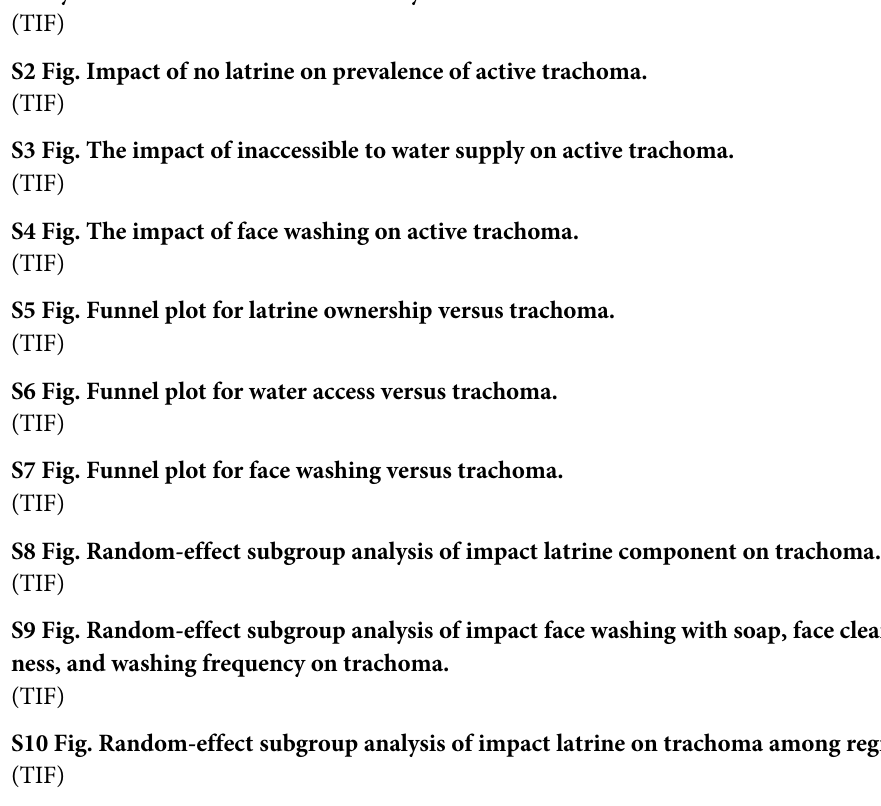
S2 Table. Summary of subgroup analysis examining the association of latrine exposures with active trachoma in Ethiopia, 2021. S3 Table. Summary of subgroup analysis of face washing with soap, frequency, and face cleanliness on active trachoma in Ethiopia, 2021. S4 Table. Newcastle–Ottawa quality assessment scale adapted for meta-analysis. S1 Fig. PRISMA flow diagram of included studies. PRISMA, Preferred Reporting Items for Systematic Reviews and Meta-Analyses. S2 Fig. Impact of no latrine on prevalence of active trachoma. S3 Fig. The impact of inaccessible to water supply on active trachoma. S4 Fig. The impact of face washing on active trachoma. S5 Fig. Funnel plot for latrine ownership versus trachoma. S6 Fig. Funnel plot for water access versus trachoma. S7 Fig. Funnel plot for face washing versus trachoma. S8 Fig. Random-effect subgroup analysis of impact latrine component on trachoma. S9 Fig. Random-effect subgroup analysis of impact face washing with soap, face cleanli- ness, and washing frequency on trachoma. S10 Fig. Random-effect subgroup analysis of impact latrine on trachoma among regions.